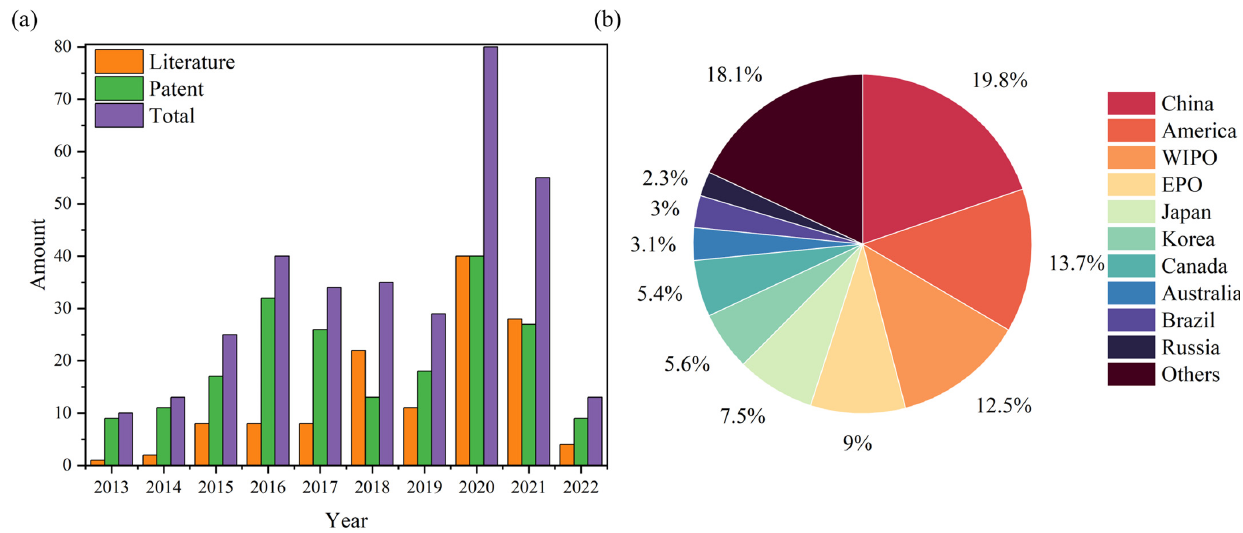
Figure 1. ( a ) Annual number of publications of papers and patents. ( b ) Patent issuance by countries and organizations between 2013 and 2022.